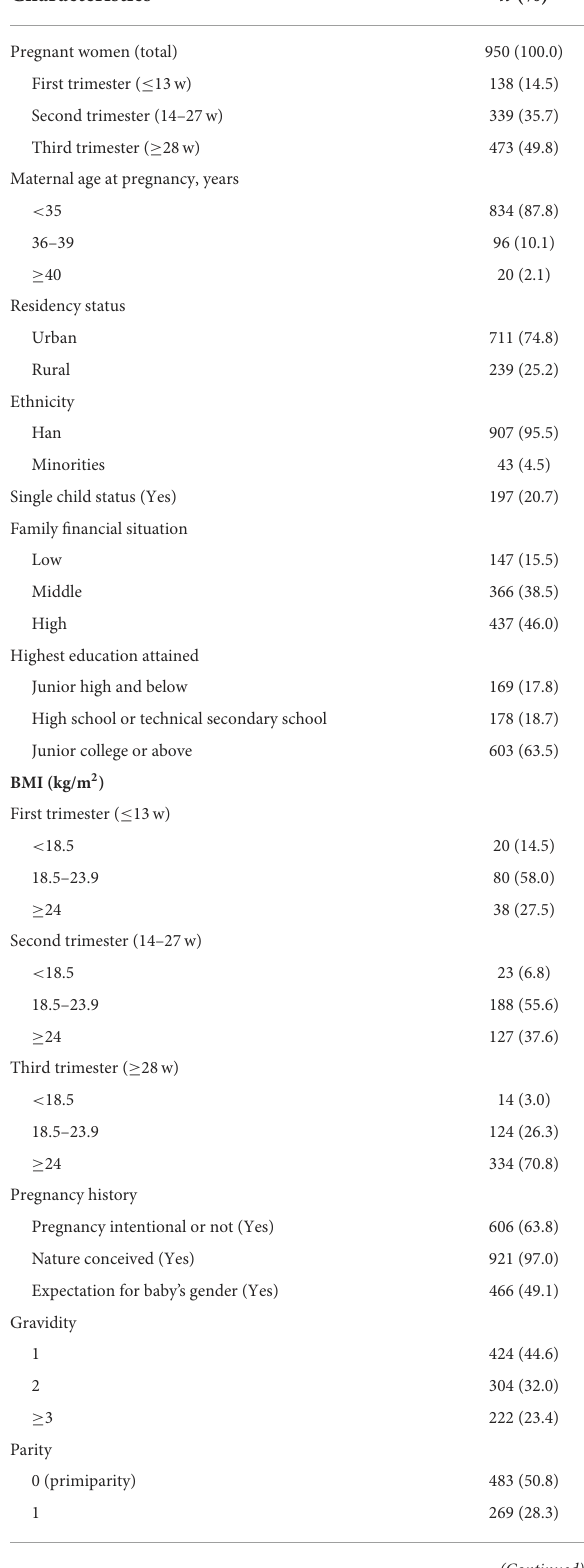
TABLE 1 Descriptive statistics of the social-demographic